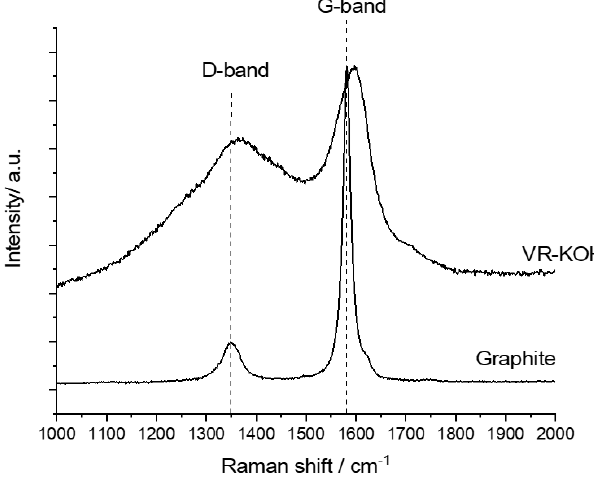
Figure 5. Raman spectra for VR-KOH and graphite powder.